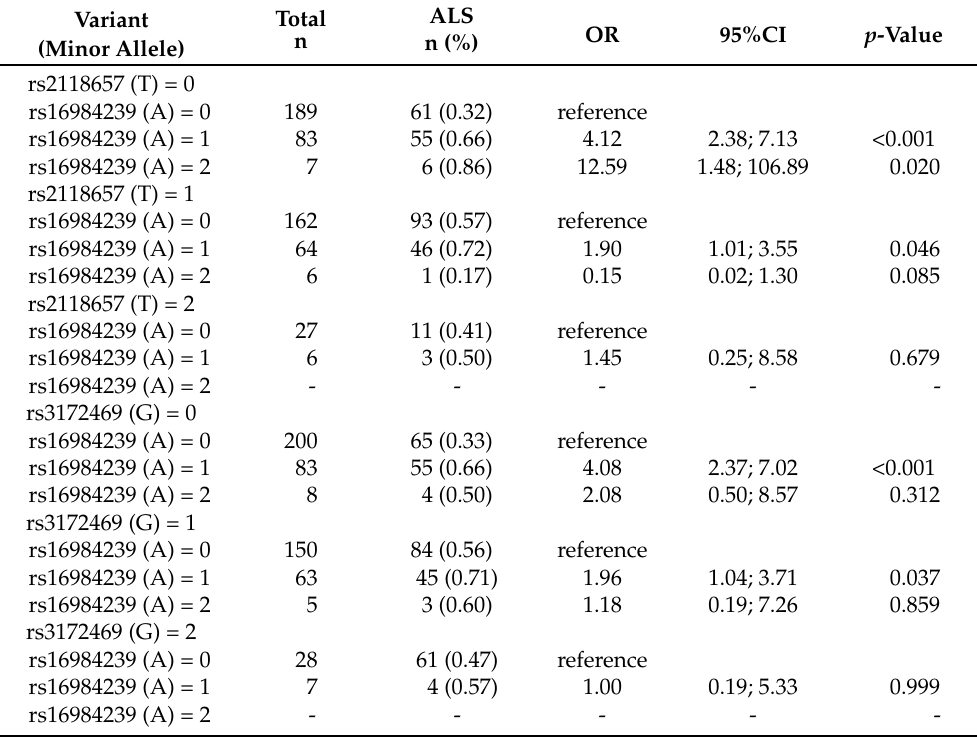
Figure 3. Distribution of the estimated coefficients for the two pairwise interactions selected in the second step group LASSO regularization. Table 3. Non-adjusted odds ratio for amyotrophic lateral sclerosis according to the selected pairwise interactions in the second step group LASSO